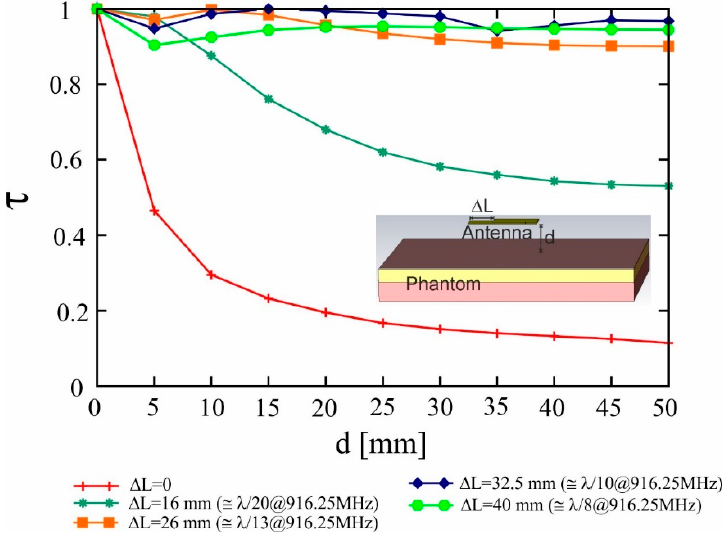
Figure 9. τ with respect to the distance from the body phantom for different extensions of the antenna ground plane.